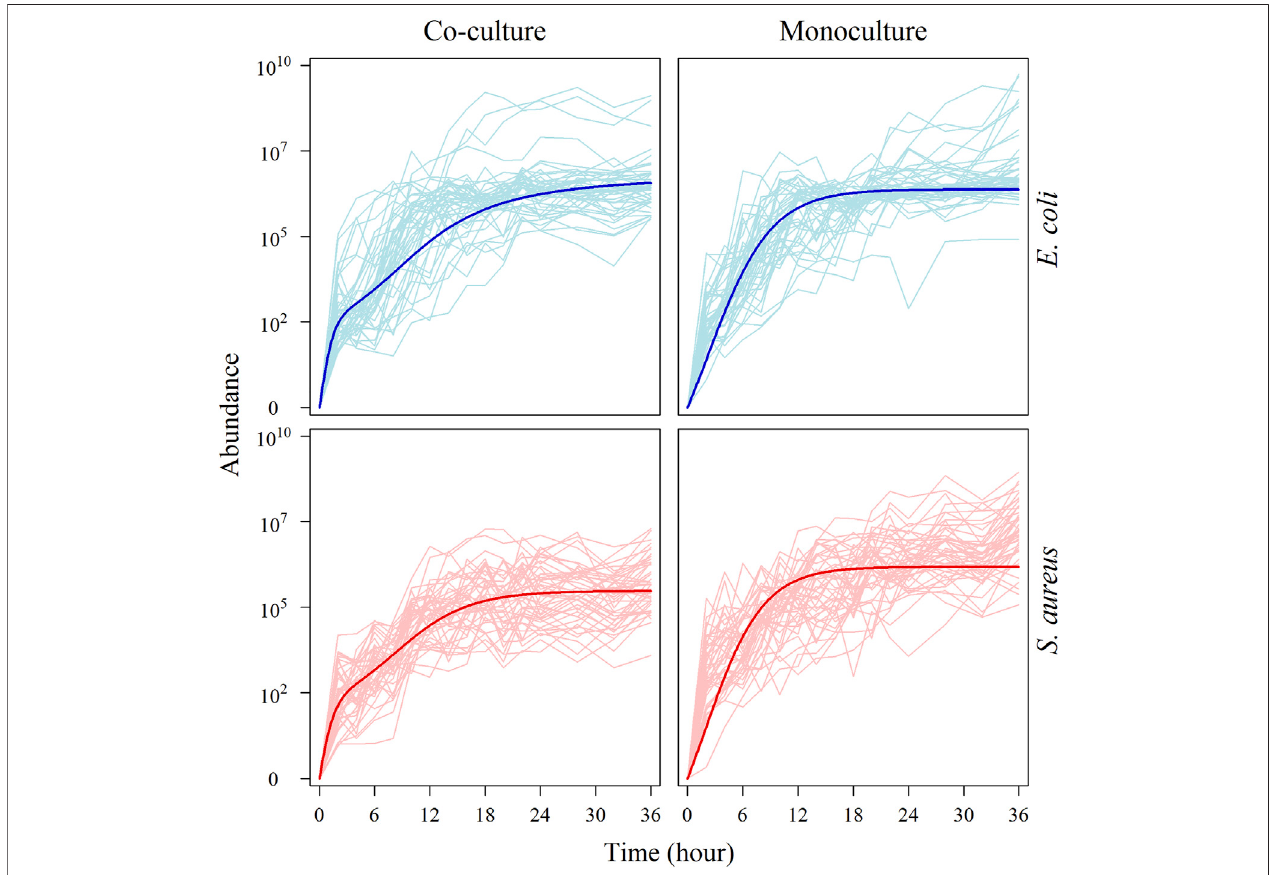
FIGURE1| Growthcurveofmicrobialabundanceundermonocultureandco-culture.Microbialabundanceofindividualstrainsfromeachspecieswasobservedin monoculture and co-culture during the fi rst 36 h after culture. The upper: the abundance curve of E. coli under monoculture and co-culture, respectively. The thick blue lineistheaveragegrowth curveof E.coli .The lower: theabundancecurveof S.aureus undermonocultureandco-culture,respectively.Thethickred lineistheaverage growth curve of S. aureus .